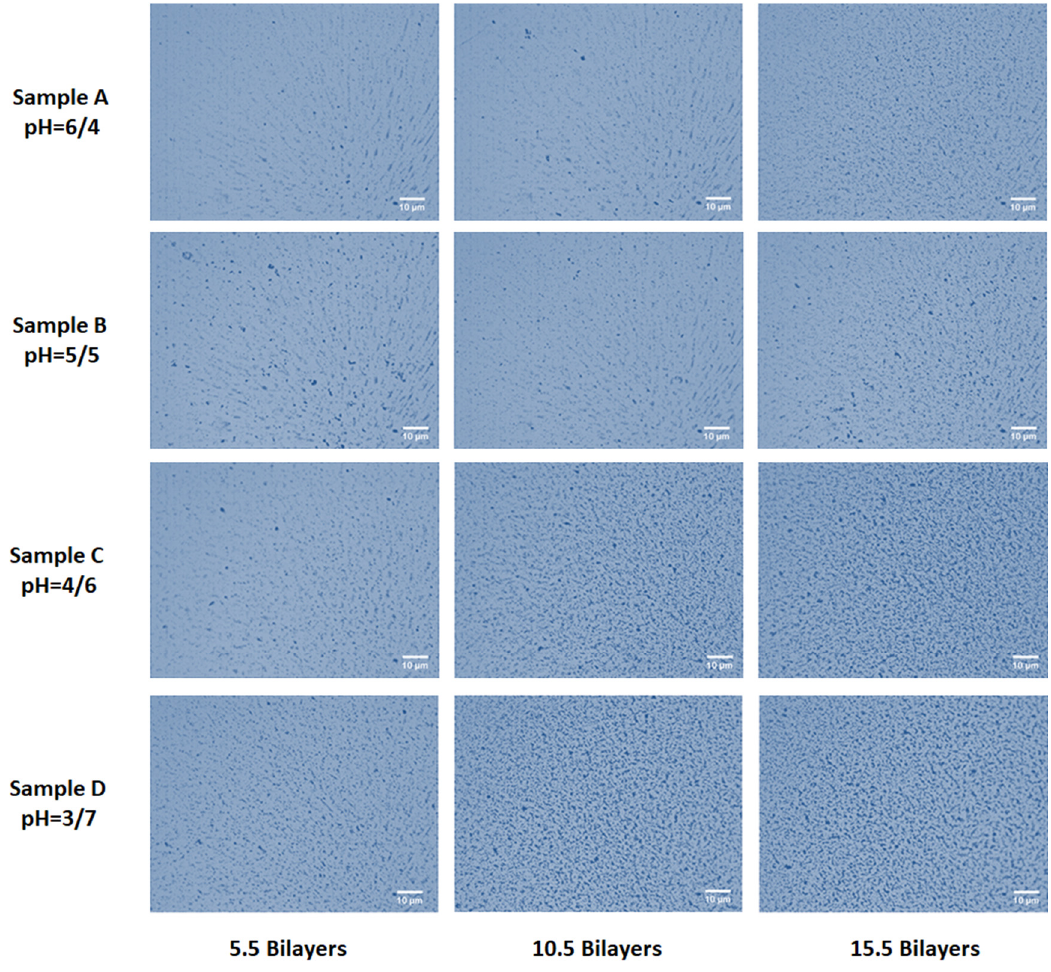
Figure 6. Optical microscopy of thin film gradients of samples A, B, C and D fabricated at various pH combinations.